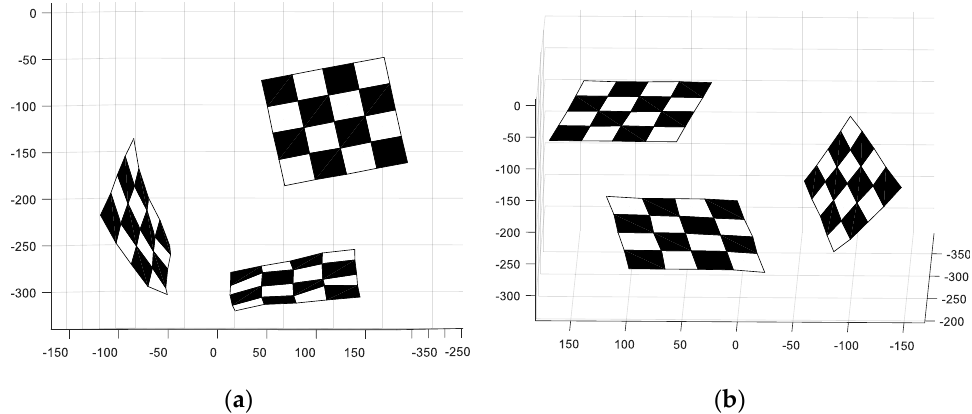
Figure 9. Three rendered views of the reconstructed trihedron. ( a ) and ( b ) are the results of different perspectives.